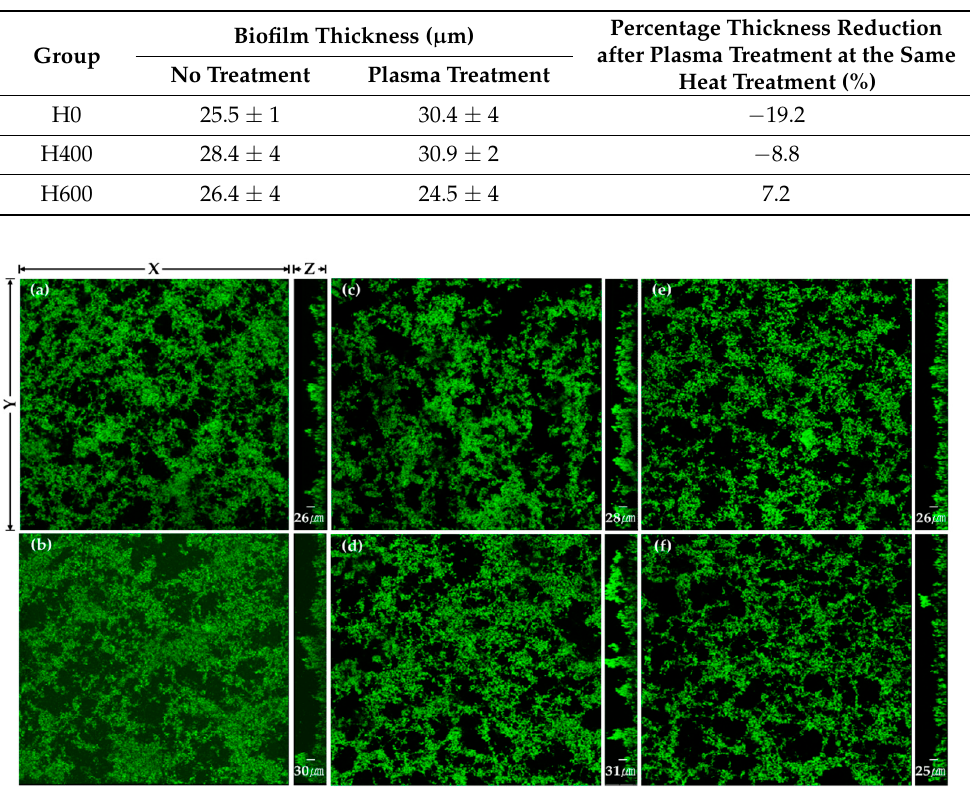
Figure 6. CLSM image of Porphyromonas gingivalis biofilm on ( a ) H0, ( b ) H0P, ( c ) H400, ( d ) H400P, ( e ) H600, and ( f ) H600P samples. Green fluorescence indicates viable cells.